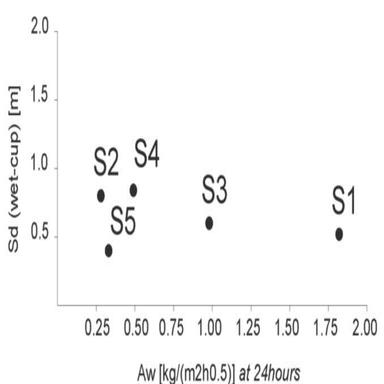
Aw (at 24 h) and sd (wet cup) obtained for the complete systems.